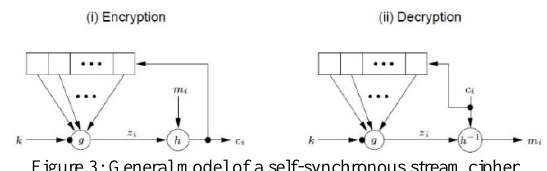
Figure 3: General model of a self-synchronous stream cipher For each type of ciphers, it has their own types of attacks. For example of the symmetric stream cipher, there are many types of attacks such as: